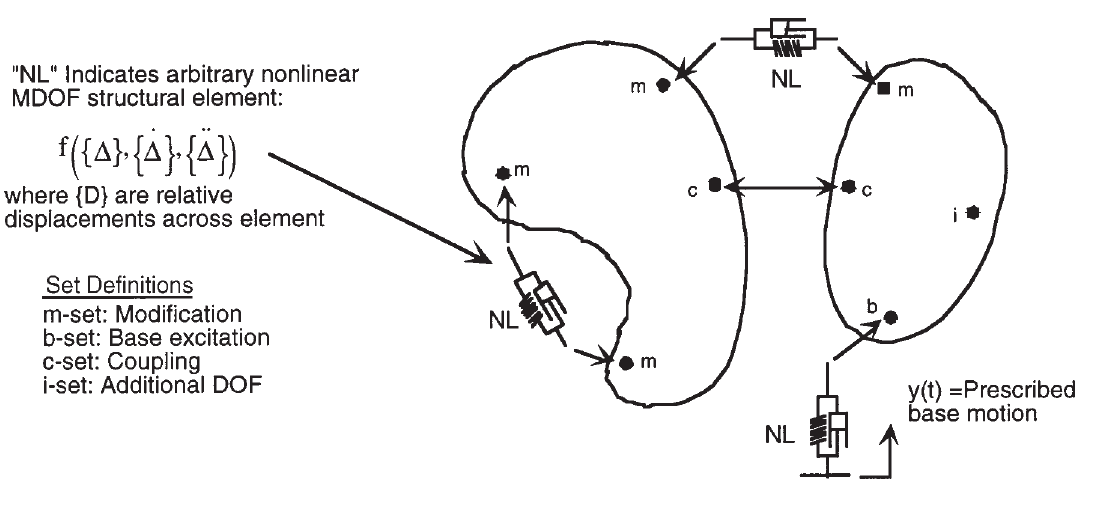
Fig. 1. General structural system for synthesis comprised of two